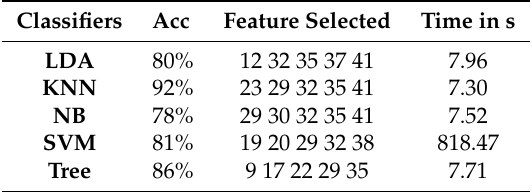
Table 8. Time taken by the algorithm to select features using various classifiers.